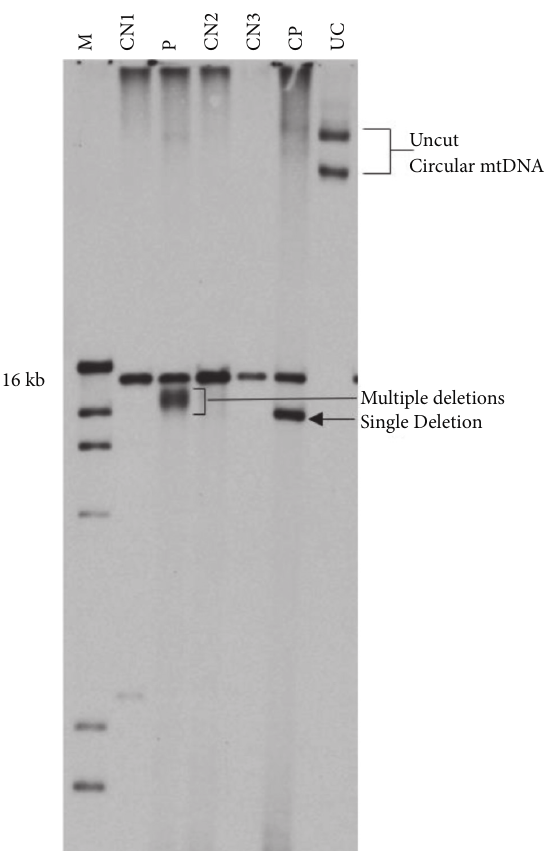
Figure 2: Southern blot for mtDNA deletion analysis. The patient’s sample (P) shows an additional band with indistinct margins localizing to a smallersizethanthe16kbexpectedforintactmtDNA.Theindistinctedgesofthebandrepresentmultipledeletions(comparedtolaneCPwithasingle deletion). Patient, P; DNA marker, M; negative controls, CN1-3; positive control with a single deletion, CP; and uncut circular mtDNA control, UC. Table 1: Summary of reported patients with the c.3104+3A > T POLG variant in compound